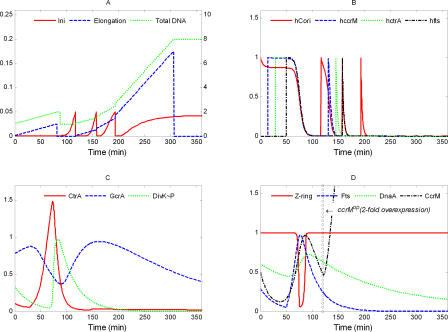
Simulation of ccrMop: k′ = 0.16 (2 × WT)